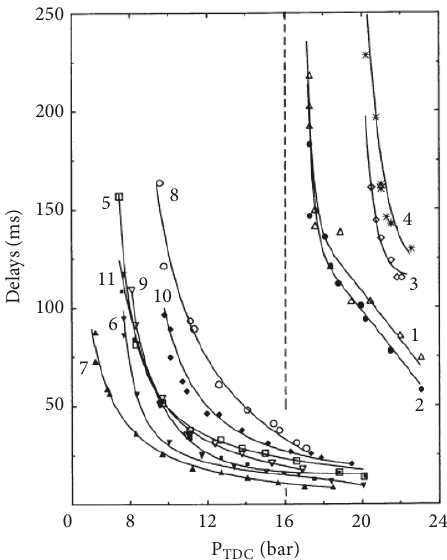
Figure 9: Autoignition delays of low alkylbenzenes around 900 K versus pressure at top dead center (TDC). Test at Φ =1, (O2)/(Inert) = 0.27 and T TDC =907 ± 6 K. Numbers correspond to the following: